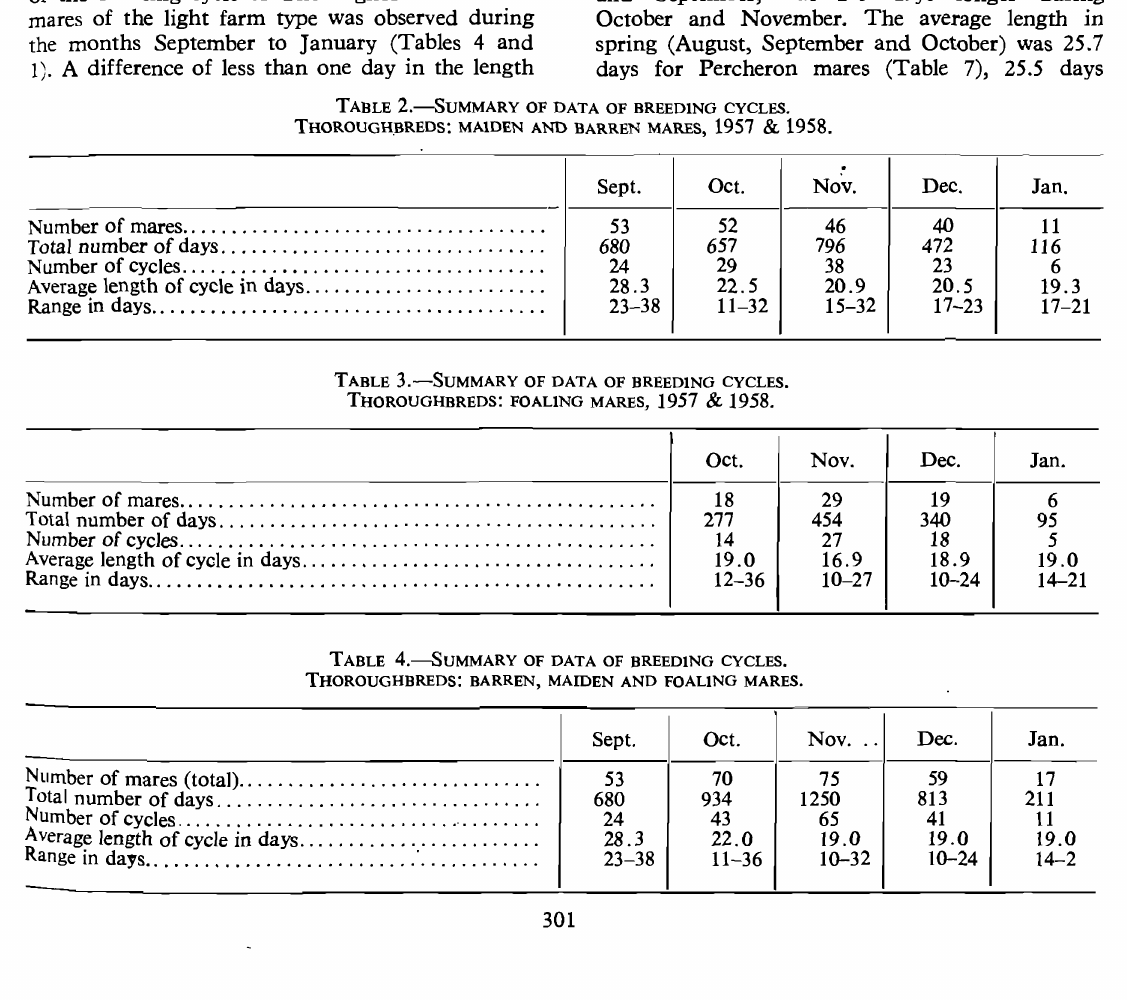
TABLE 4.-SUMMARY OF DATA OF BREEDING CYCLES. THOROUGHBREDS: BARREN, MAIDEN AND FOALING MARES.